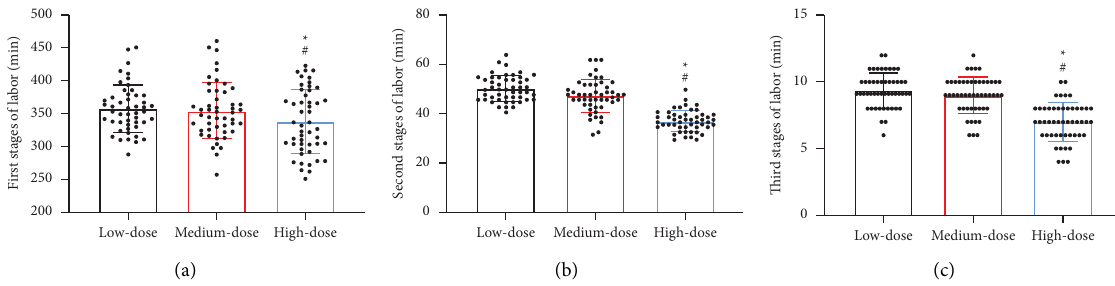
Figure 2: Comparison of duration of labor. (a) Comparison of frst stages of labor. (b) Comparison of second stages of labor. (c) Comparison of third stages of labor. Note . Compared with the low-dose group, ∗ P < 0 . 05; compared with the middle-dose group, # P < 0 . 05.